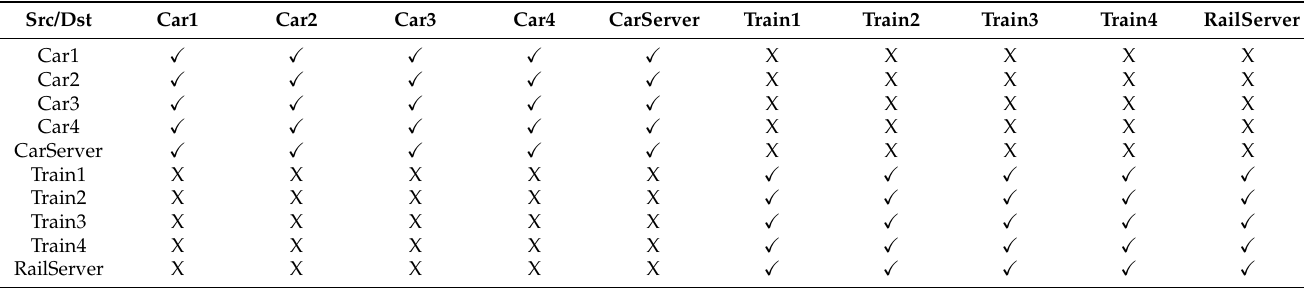
Table 6. Reachability